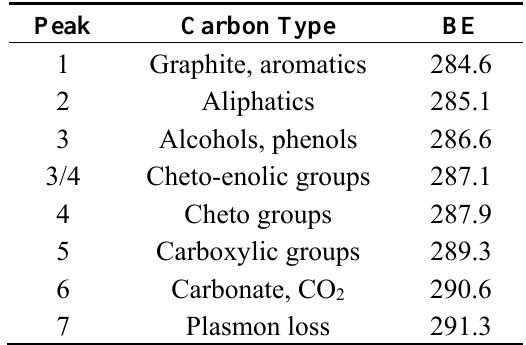
Figure 3. Curve fitting of a C 1s detail scan relevant to a sample of oxidized carbon fibers [24]. Experimental spectrum: dotted curve; synthesized resultant (background + peaks): continuous line. The residual window at the bottom of the figure shows the (properly expanded) difference between experimental and synthesized spectra. The asymmetric peak 1 is assigned to graphitic carbon atoms. Symmetrical peaks 3, 4 and 5 are assigned to C–OH, C=O and O–C=O groups. Table 1. C 1s binding energies (eV) of some types of carbon atoms